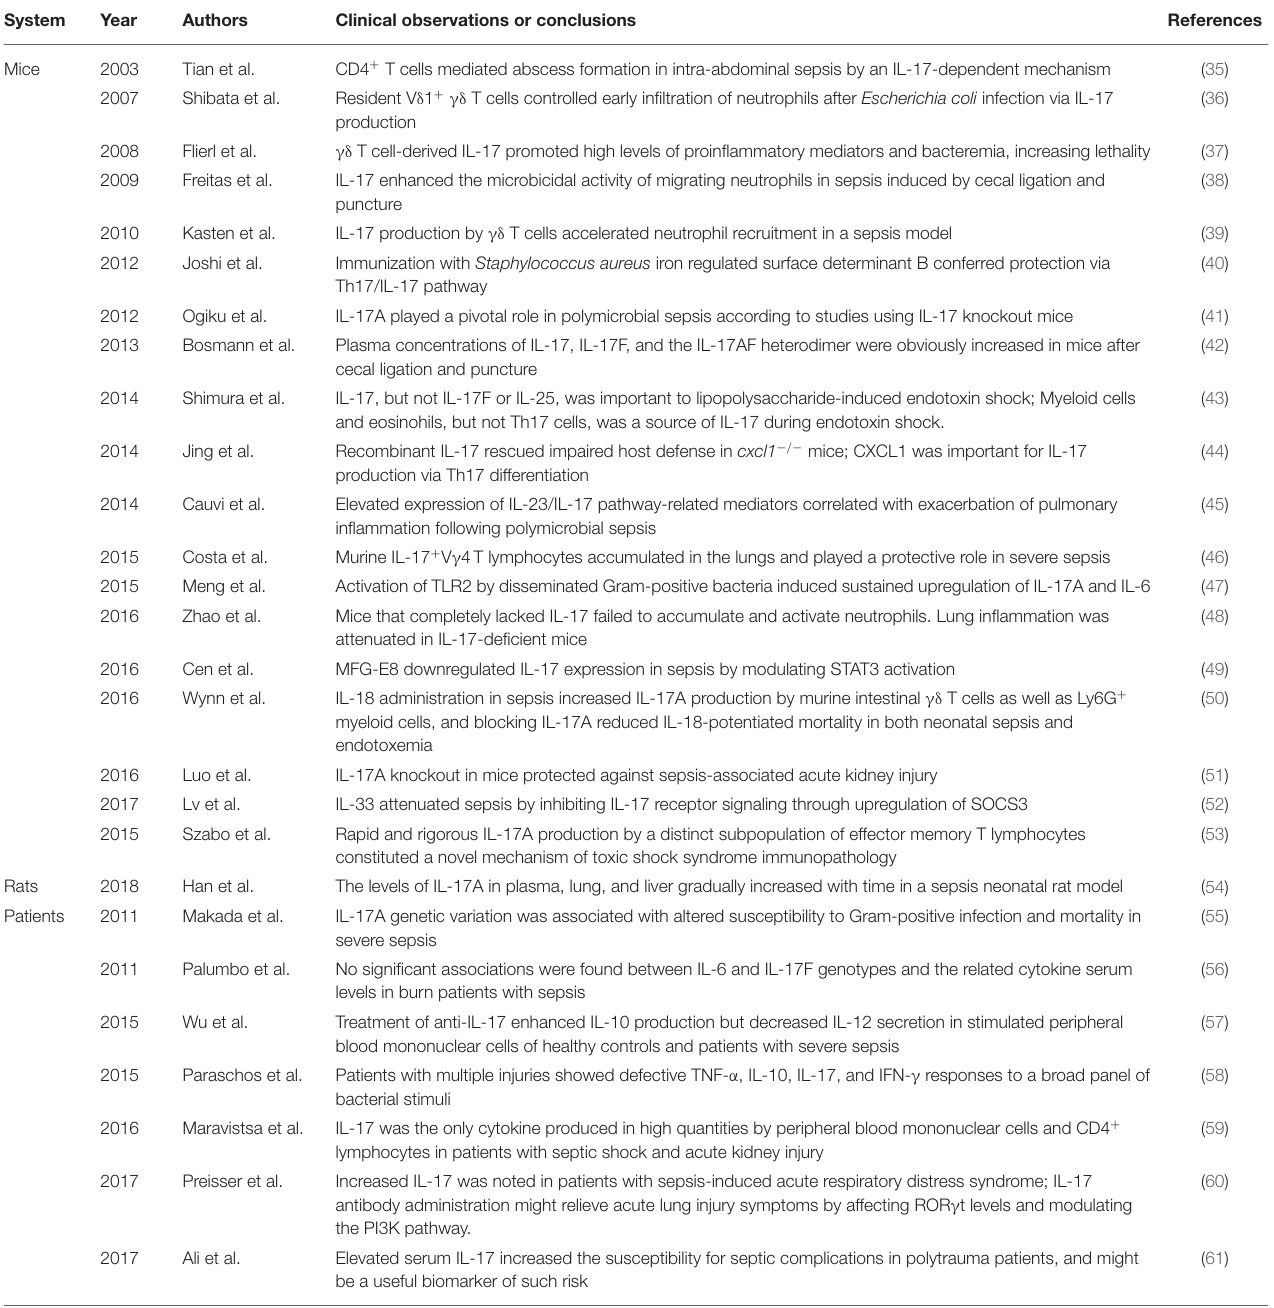
TABLE 1 | Summary of studies on the pathophysiological significances of IL-17 in sepsis.